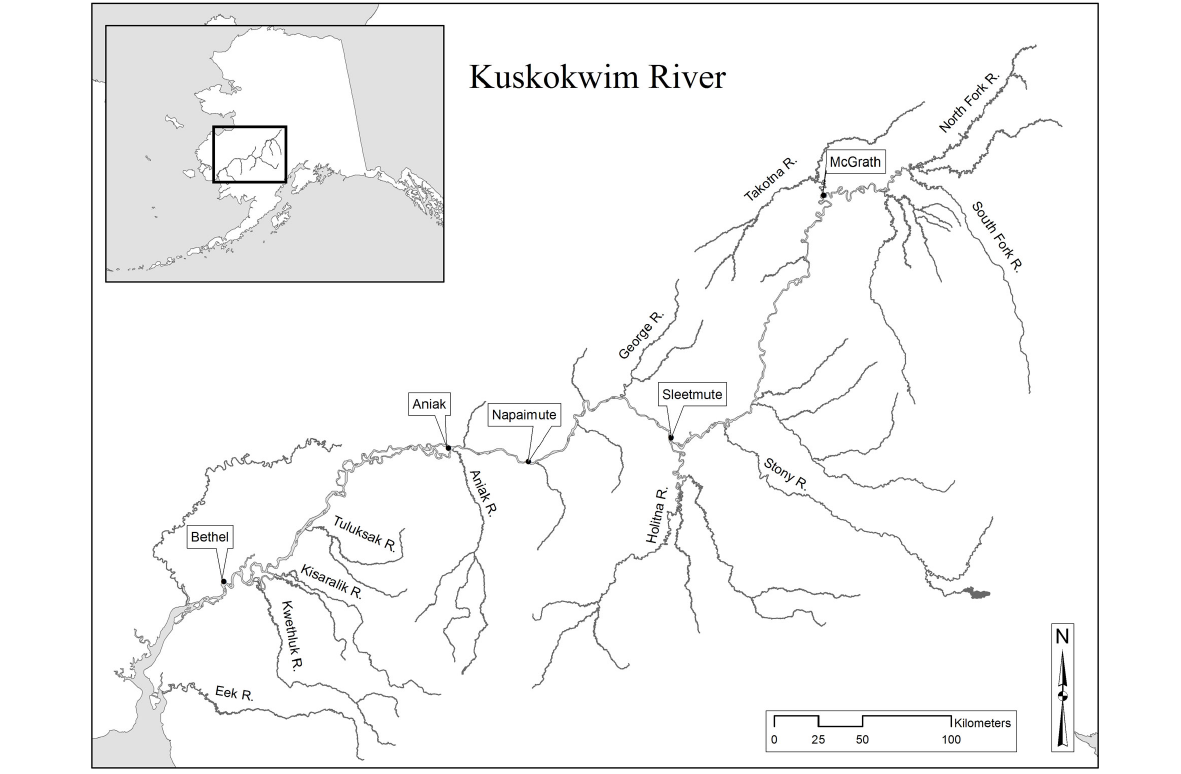
Fig. 1 . Map of Alaska. The Kuskokwim region is located in the southwest corner of Alaska. Image from Alaska Department of Fish and